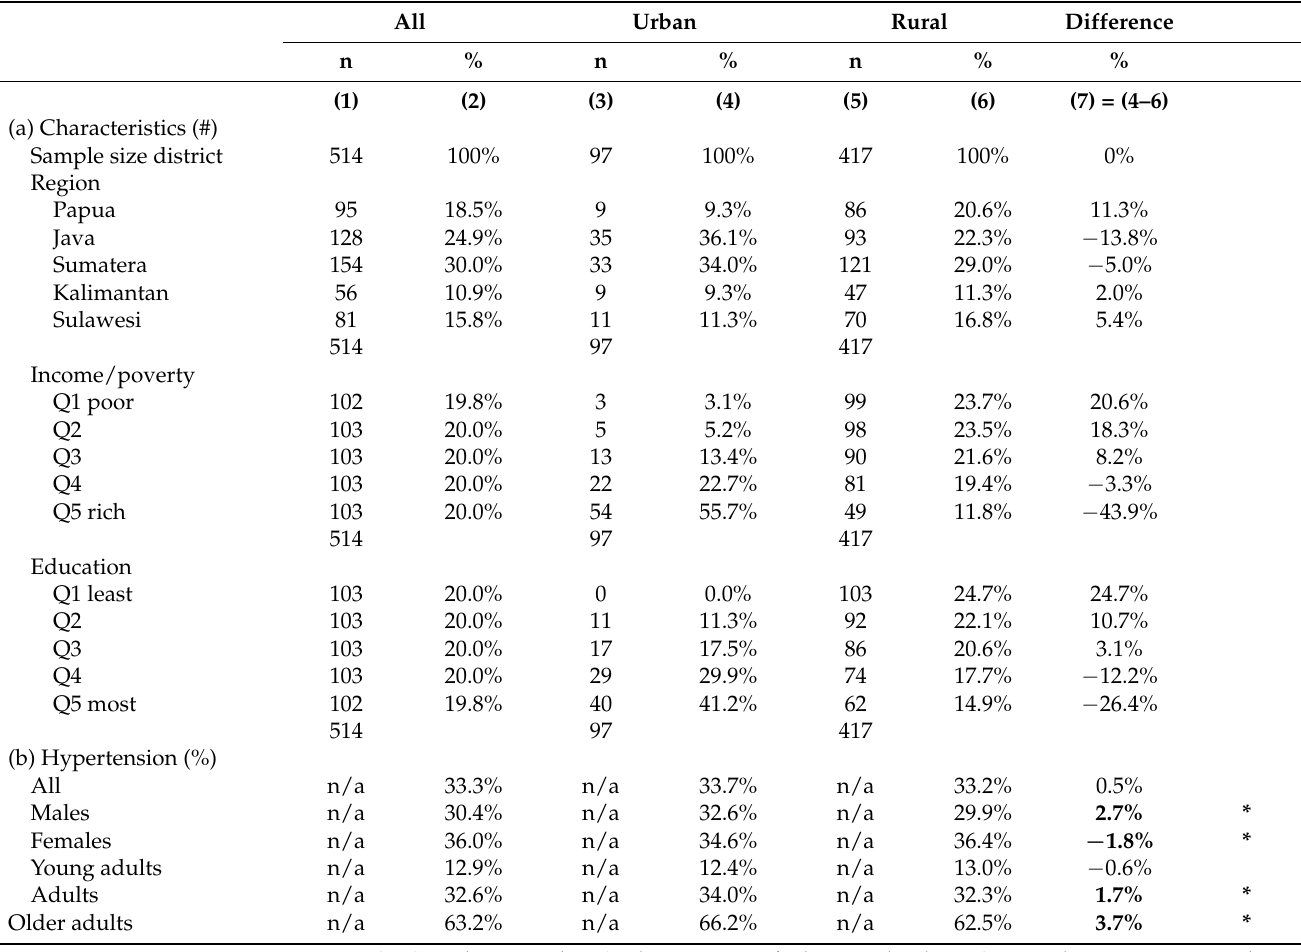
Table 2. Characteristics of districts and hypertension among